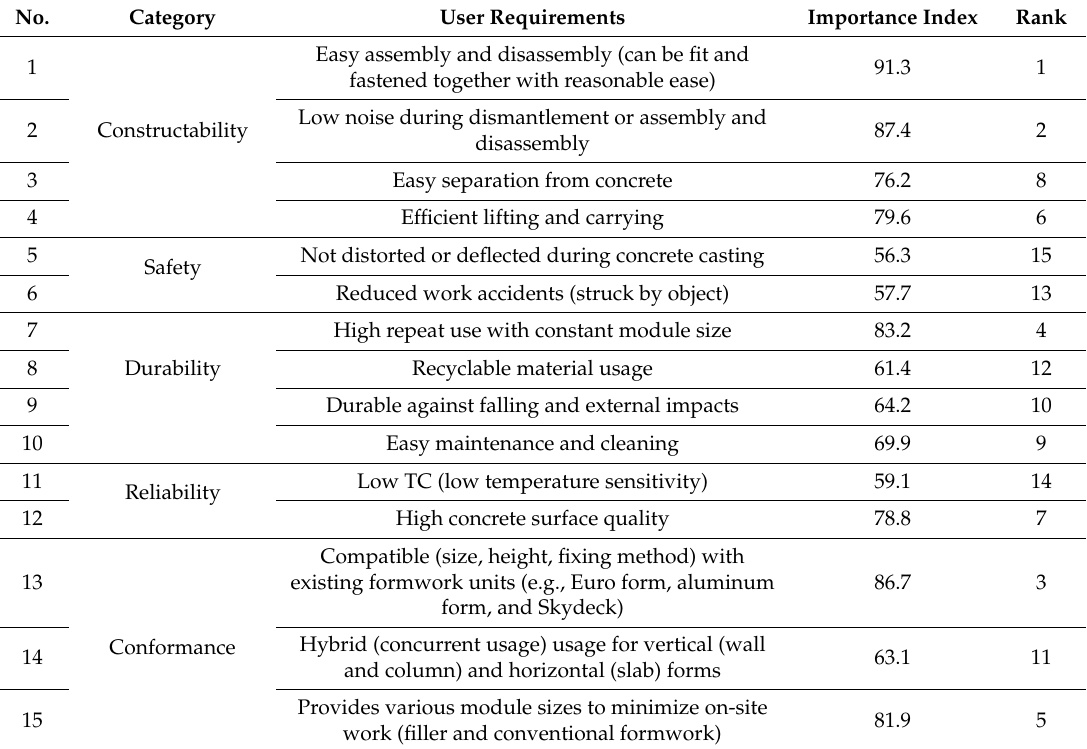
Table 3. User requirements for